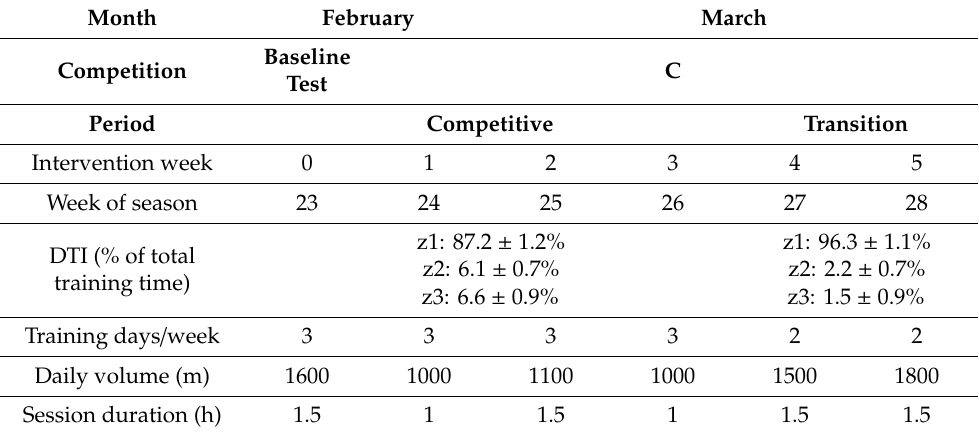
Table 1. Characteristics of competitive and transition period in Macrocycle 1.